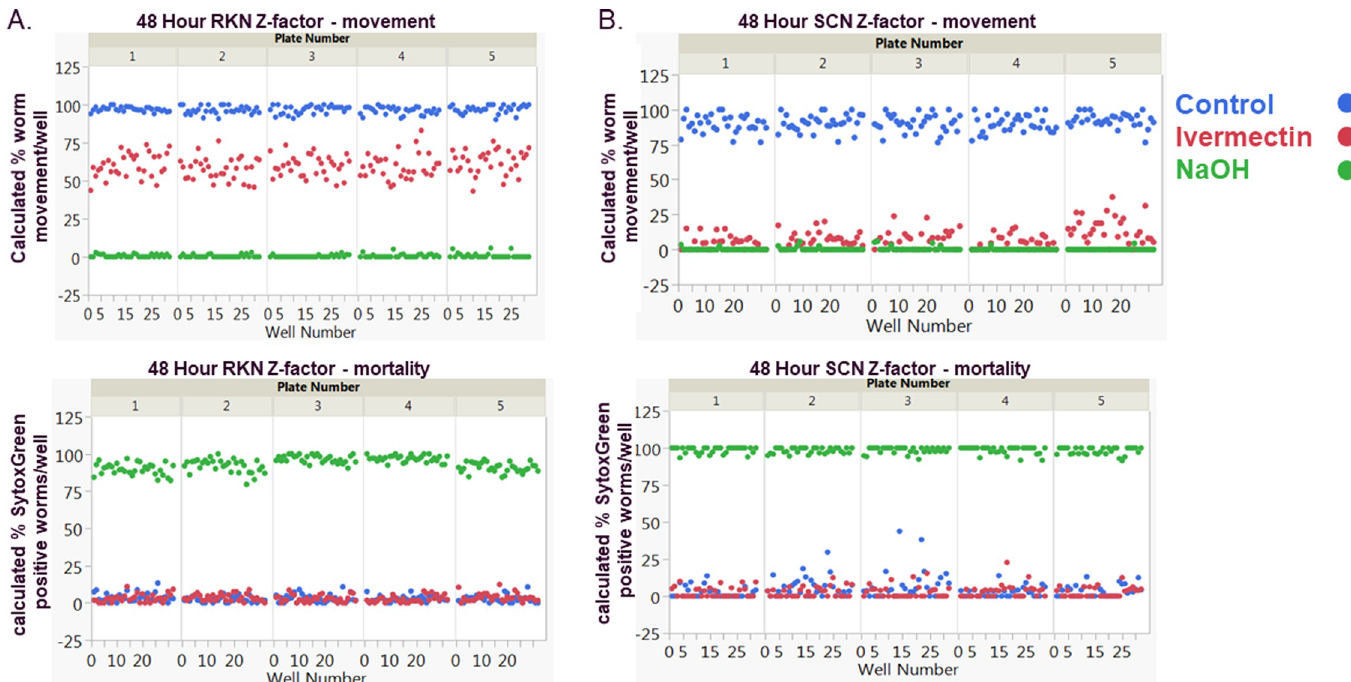
Fig 2. Representative data from a single day and time point of a 3-day set of experiments. Calculated average Z’-factors of the 3 days of 5 plates (n = 15 plates total representing 480 wells) for mortality based on 0.1%NaOH ( A .), and movement for both 10 μ M ivermectin ( B. ). Images were captured at 24 hours, 48 hours and 6 days of treatment and all images transformed with Cell Developer software based on the algorithm described in the Methods section. Percent CV was calculated from the mean calculated Z’-factor for each individual day.